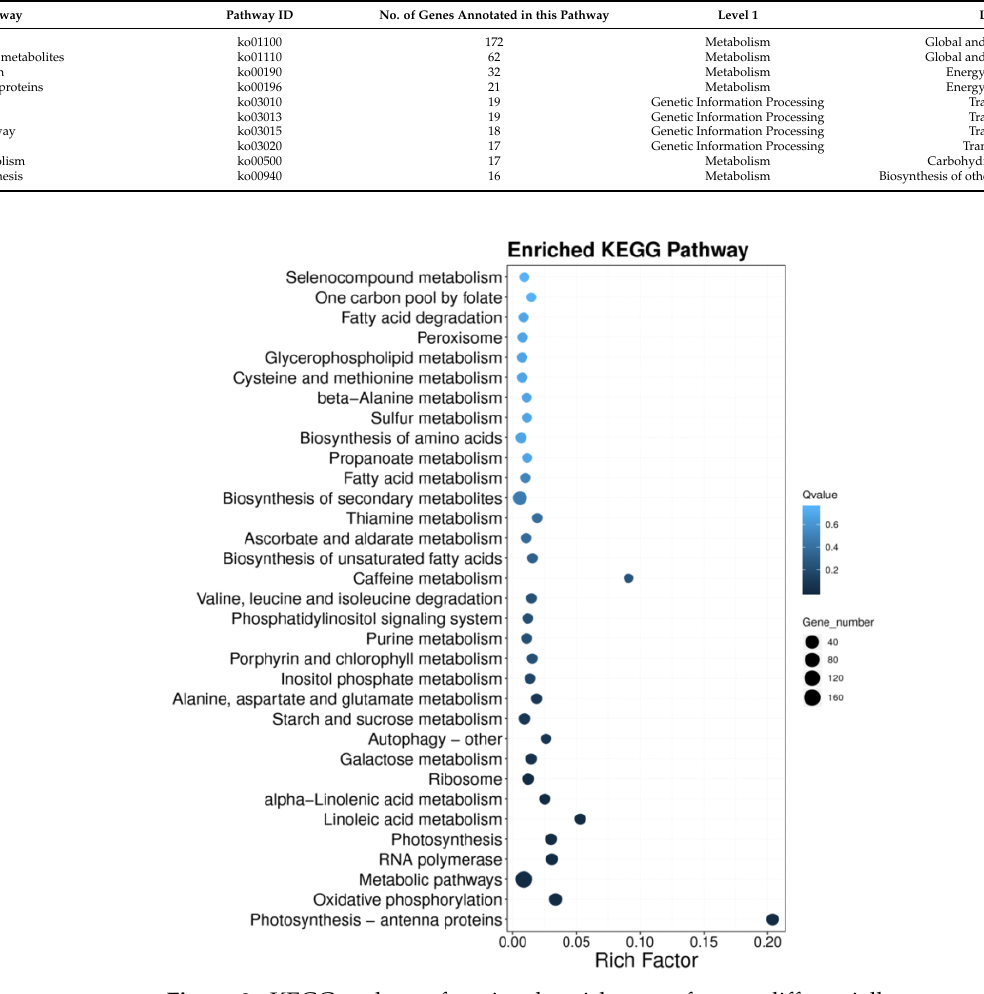
Figure 3. KEGG pathway functional enrichment of genes differentially expressed in high-B (TB 10 mM)-treated shoots of the T. dicoccum (Td) genotype, PI94655 compared to 3.1 µM B (control) treatment. While the enrichment factor is presented on the X axis, the pathway name is shown on the Y axis. The lower (blue) q-value denotes the more significant enrichment, while the higher (white) q-value denotes the less significant enrichment. Point size shows the number of DEGs.